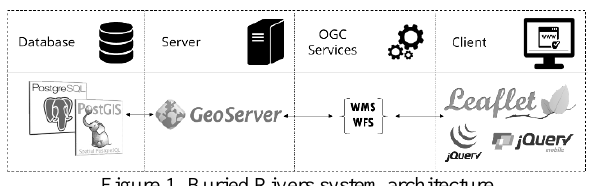
Figure 1. Buried Rivers system architecture